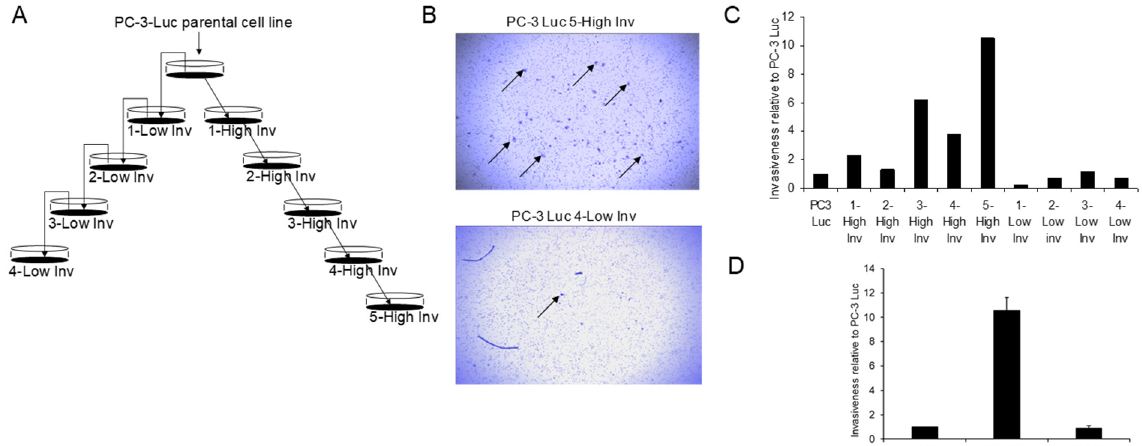
Figure 1. Development of invasive and non-invasive lines of PC-3 Luc. ( A ) Schema of selection of high and low invasive PC-3-luc cell lines. PC-3-Luc cells were placed in a BioCoat Matrigel Invasion Chamber. After 12 h, cells that had invaded through the membrane or stayed on top of the membrane were isolated to create high or and low invasive cells, respectively. This process was repeated as indicated. ( B ) The lower membrane was stained to demonstrate the in vitro invasiveness of invasive cells. Arrows, PC-3 Luc cells. ( C ) Relative invasiveness of successive generations of PC3-Luc lines selected on their ability to invade compared to parental PC-3 cells. ( D ) Invasiveness of final selected high and low invasive cells relative to the parental PC-3 Luc cells (measured in triplicate) Data shown as mean ± SD.